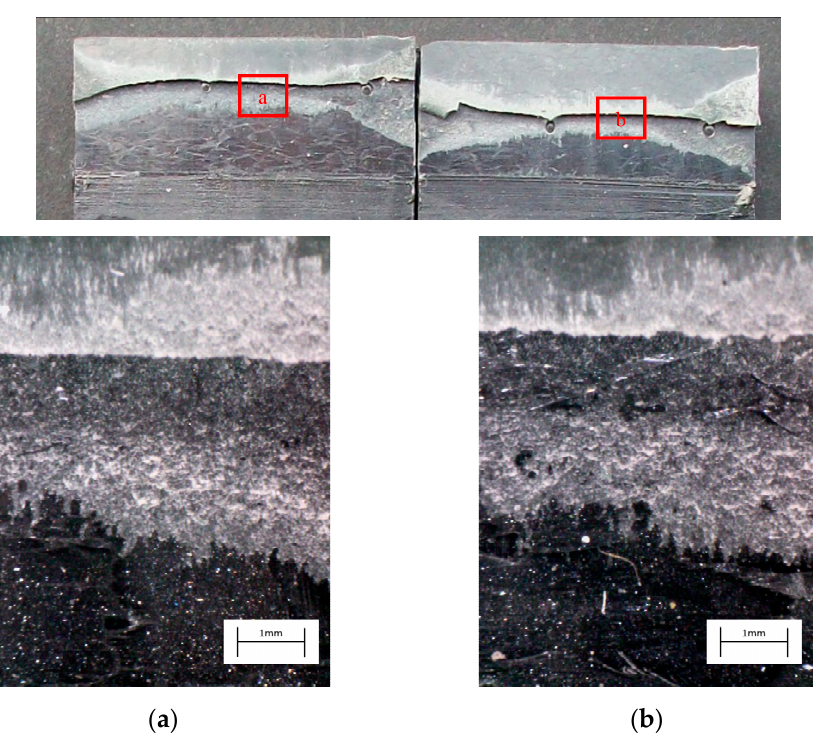
Figure 22. Fracture surface of a specimen pretreated with APPT with D = 5 mm and v = 100 mm/s and subjected to fatigue test, with magnified details ( a ) and ( b ) acquired by microscope.